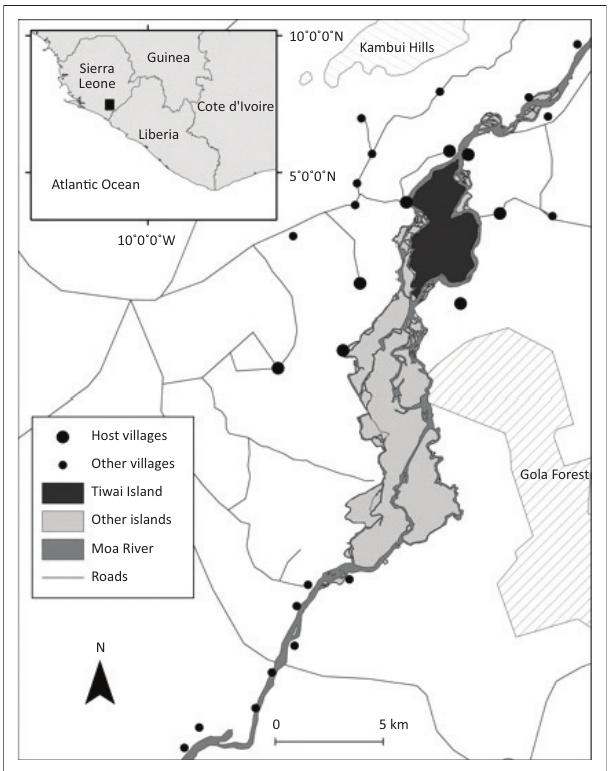
FIGURE 1: Tiwai Island Wildlife Sanctuary, Lower Tiwai, and the surrounding small islands in eastern Sierra Leone, surveyed using camera traps during